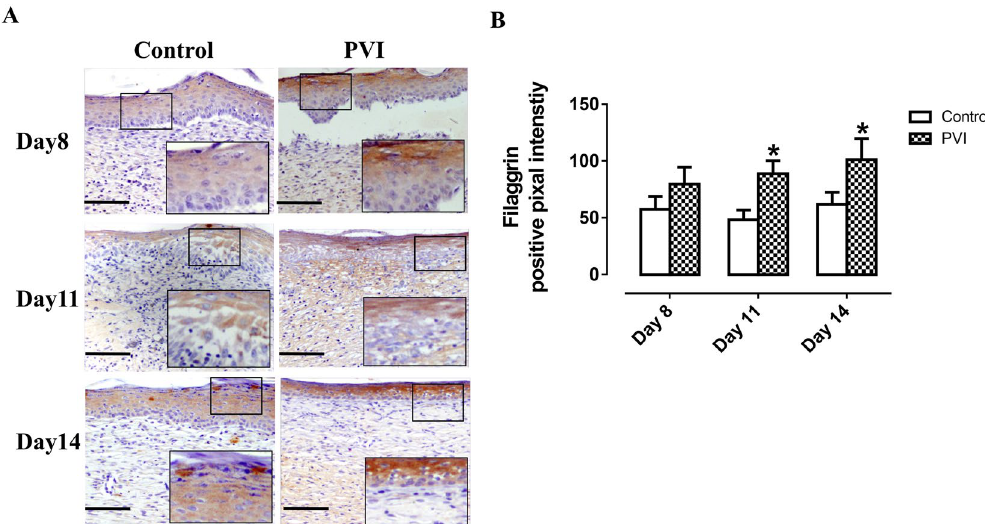
Figure 7. Povidone-iodine (PVI) treatment enhanced filaggrin expression. ( A ) Representative immunohistochemical filaggrin stained wound sections. Scale bar = 50 μ m. ( B ) Semi-quantitative analysis of filaggrin expression. * p < 0.05 vs control. Data are means ± S.D, n =